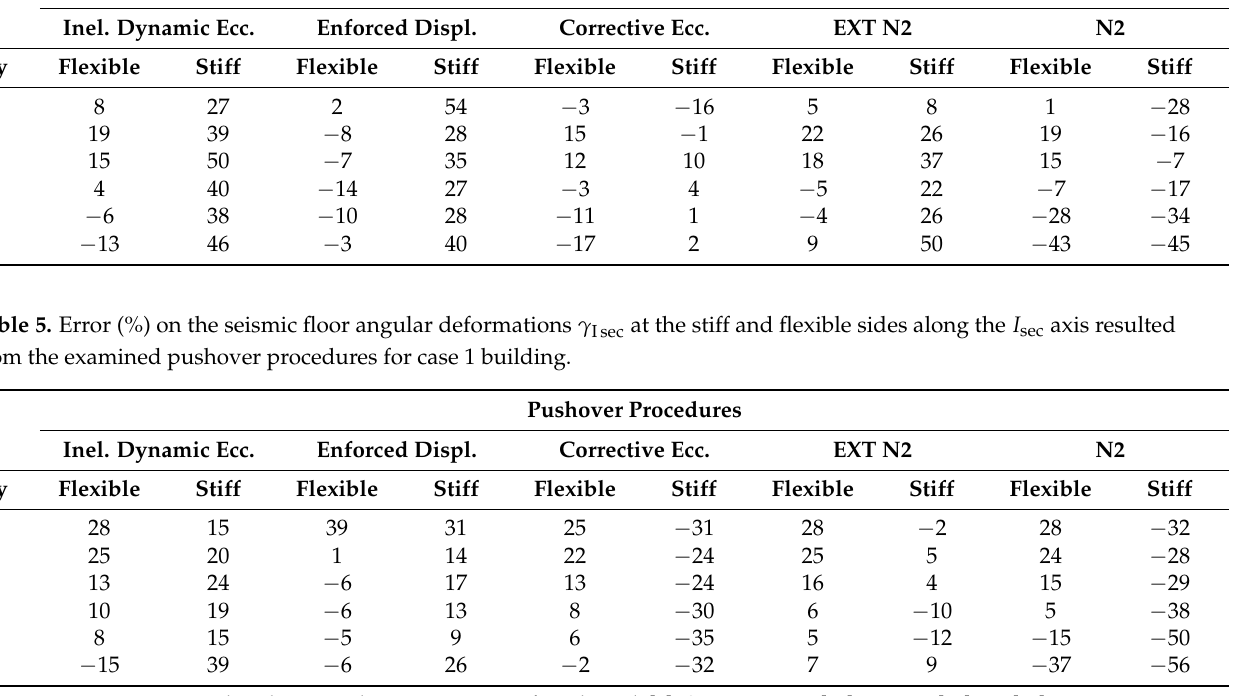
Table 4. Error (%) on the seismic floor angular deformations γ IIsec at the stiff and flexible sides along the II sec axis resulted from the examined pushover procedures for case 1 building.